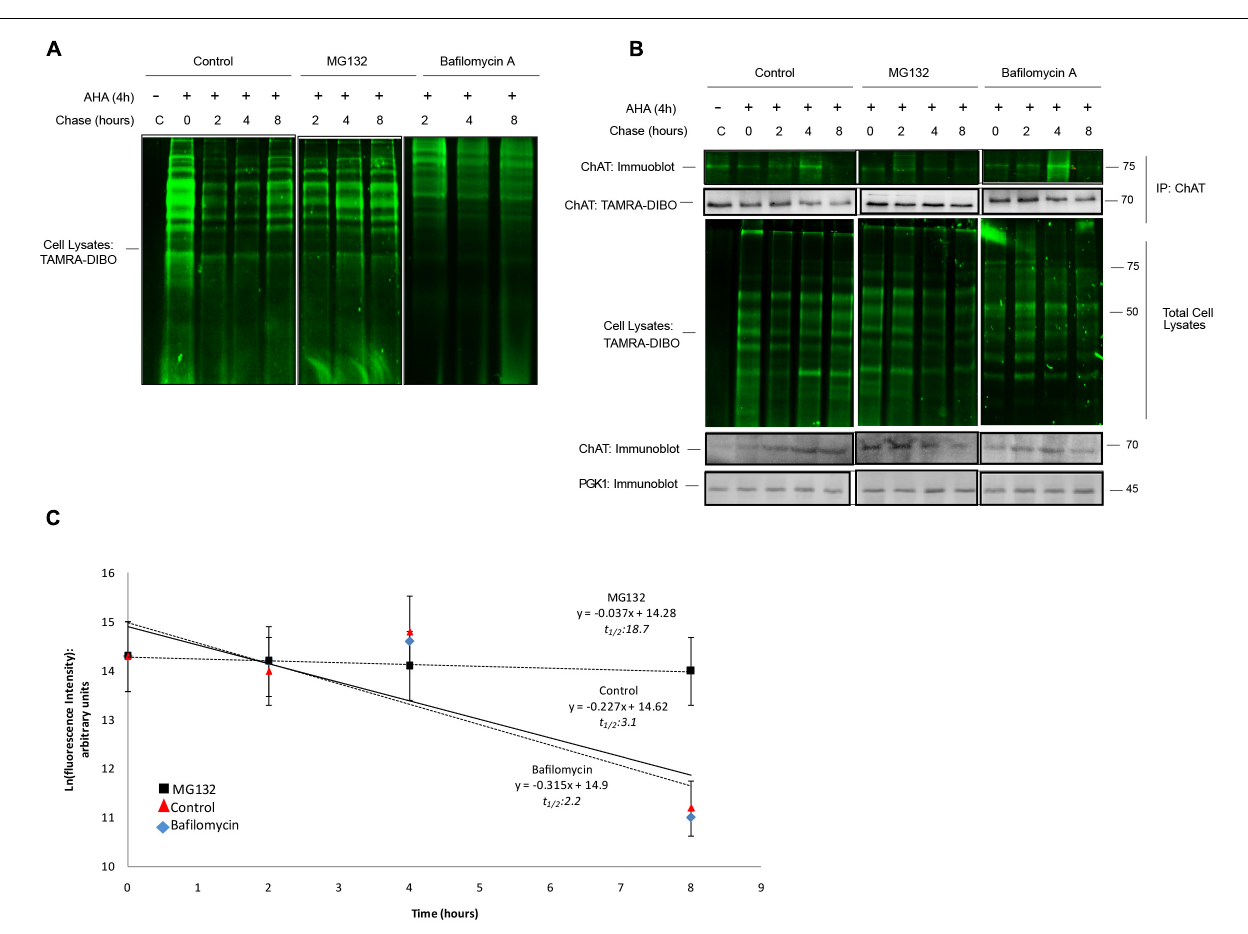
FIGURE 6 | SPAAC pulse-chase analysis of ChAT protein half-life in yeast. (A) Fluorescence detection of total AHA-labeled proteins from BY (cid:49) pdr5 yeast cells following SPAAC pulse-chase (24 h AHA pulse, 0–8 h methionine chase) and labeling with the strained cyclooctyne TAMRA-DIBO. Cells were co-treated with either 50 µ M MG132 or 10 µ M Bafilomycin A throughout both the 24 h AHA-pulse and 8 h chase periods to inhibit the proteasome or lysosome, respectively. Control unlabeled cells were incubated in media with methionine (i.e., without AHA). (B) Fluorescence detection of immunoprecipitated (IP) AHA/TAMRA-labeled human ChAT protein from ChAT-expressing BY (cid:49) pdr5 yeast cells following SPAAC pulse-chase with the strained cyclooctyne TAMRA-DIBO. Fluorescent AHA/TAMRA-labeled proteins from either whole cell lysates or anti-ChAT IPs were detected in resolved SDS-PAGE gels at an Ex/Em of 555/580 nm. Anti-ChAT and anti-PGK1 immunoblots were completed on AHA/TAMRA-labeled protein samples for downstream data analysis and as loading controls. (C) Proteasome inhibition by MG132 treatment increased the protein half-life of human ChAT (18.7 h) as compared to DMSO-treated control yeast cells [3.1 h; F (1,46) = 5.6432, p ≤ 0.001]. Bafilomycin A co-treatment had no significant effect on the half-life of AHA/TAMRA-labeled ChAT (2.2 h). ChAT fluorescence intensities from (B) were plotted on a semi-logarithmic scale and linear regression was completed to determine human ChAT protein half-life ( n =